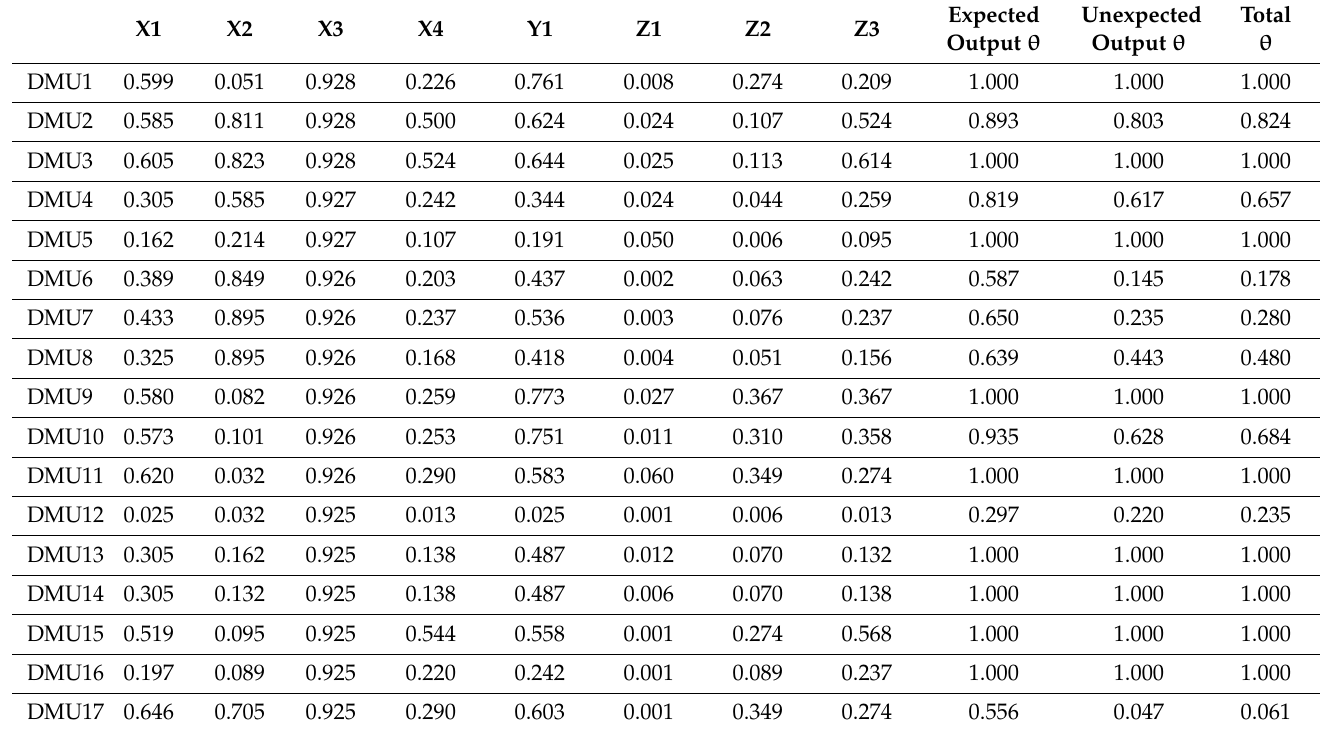
Table 4. Solution for the 17 sample DMUs via the SBM-DEA with an unexpected output